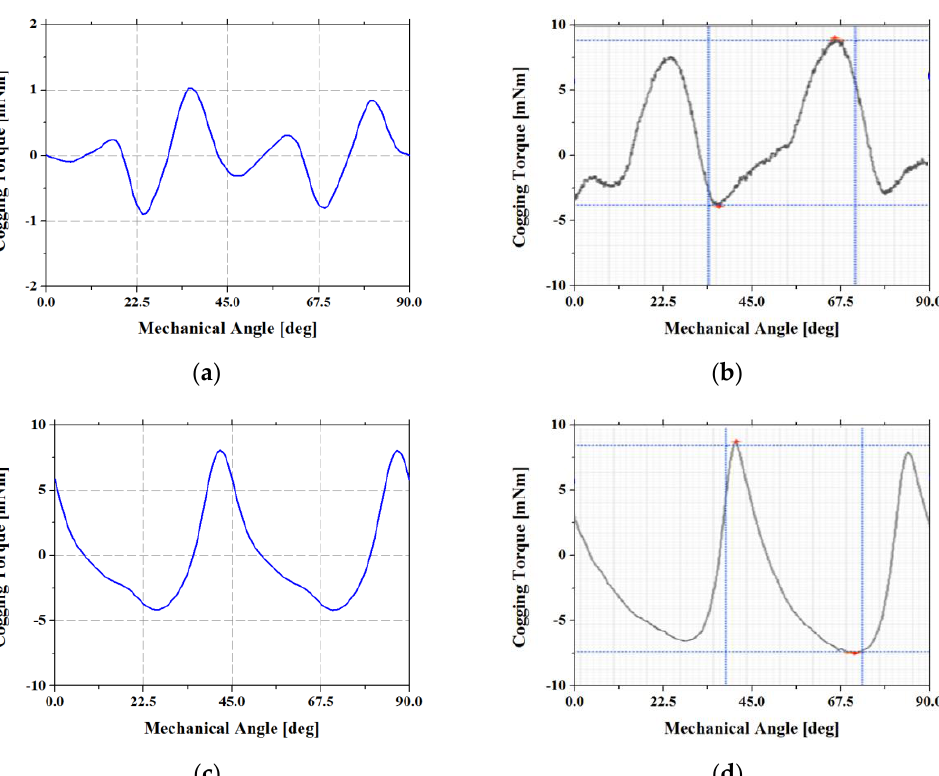
Figure 22. Experimental environment.